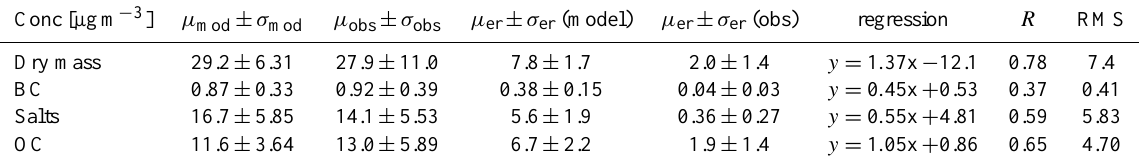
Table 7. Daily average mean (column-average) modeled (µ mod ) and observed ( µ obs ) (near-surface) mass concentration (µgm − 3 ) together with corresponding standard deviations ( σ) , mean and standard deviation errors in model and observations ( µ er ± σ er ), regression slope and offset, correlation coefficient ( R ), and root-mean-squared deviations (RMS) for non-suspect data during the first half of May 2008. Inorganic salts (“Salts”) is the sum of the mass concentrations of SO 4 , NH 4 and NO 3 ions.